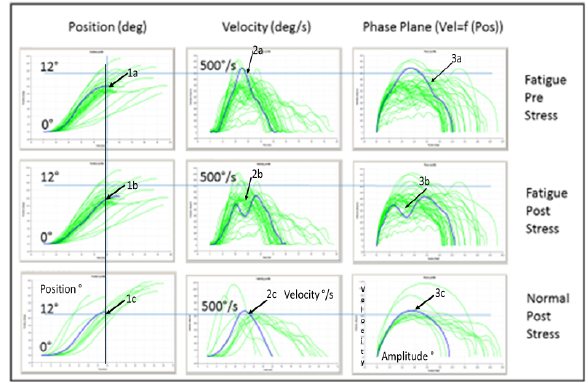
Figure 1. Characteristics of amplitude, velocity, velocity/ampli- tude phase-plane of MS fatigue patient SC. Before [pre] and after [post] stress test (upper two rows). Median curves of 30 samples. For comparison, lowermost row shows corresponding graphs of a healthy subject (KF) after stress test, with normal dynamic and phase-plane graphs, even after the stress test . Note the saccadic amplitude reduction (arrow 1b) and significant reduction of peak velocity (2b) after the stress test, compared to before stress test (1a and 2a); falling below the two sigma main sequence limits of healthy subjects aged 20 to 60 in our lab. Note also the typical dynamical fatigue effects of the patient´s saccades with double velocity peaks (2b) [already slightly indicated before stress test (2a)]. Double saccades (3b) and asymmetrical (3a) phase-plane graphs demonstrate this result as well. Axes. Ordinates: Left: position, deg. Middle and right: velocity, deg/s. Abszissae: Time, 0 to 100 ms. Left vertical line depicts time when final saccadic amplitude has been reached: after 35ms (lowermost: normal), uppermost and middle (fatigue) after 50ms and 60ms respectively.